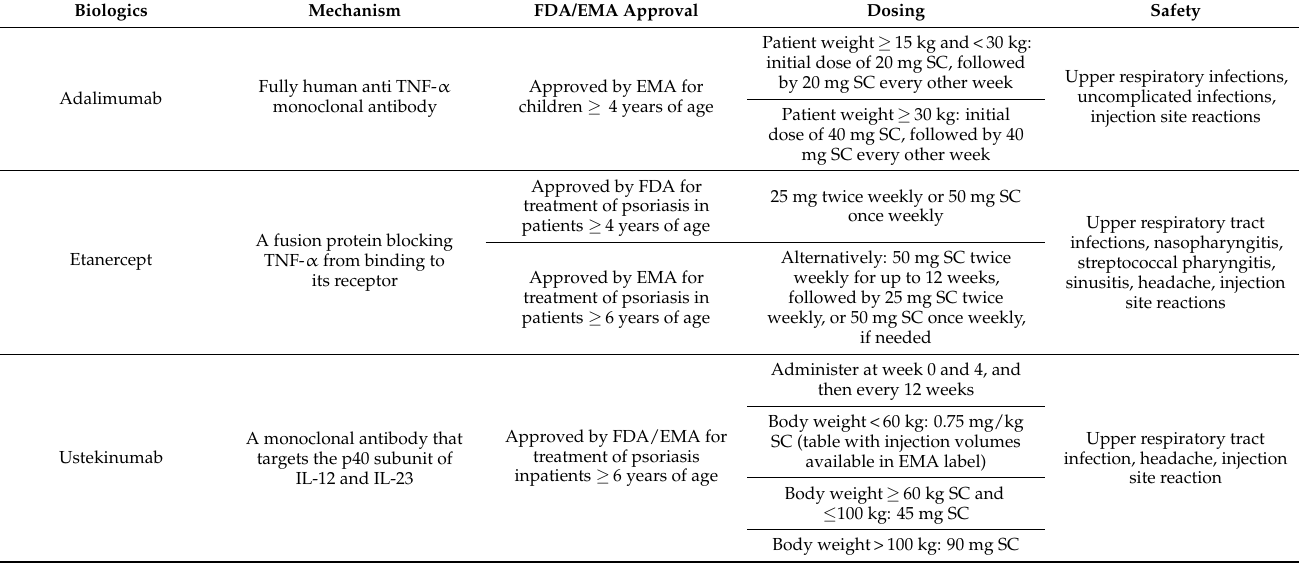
Table 1. Biologics approved for pediatric